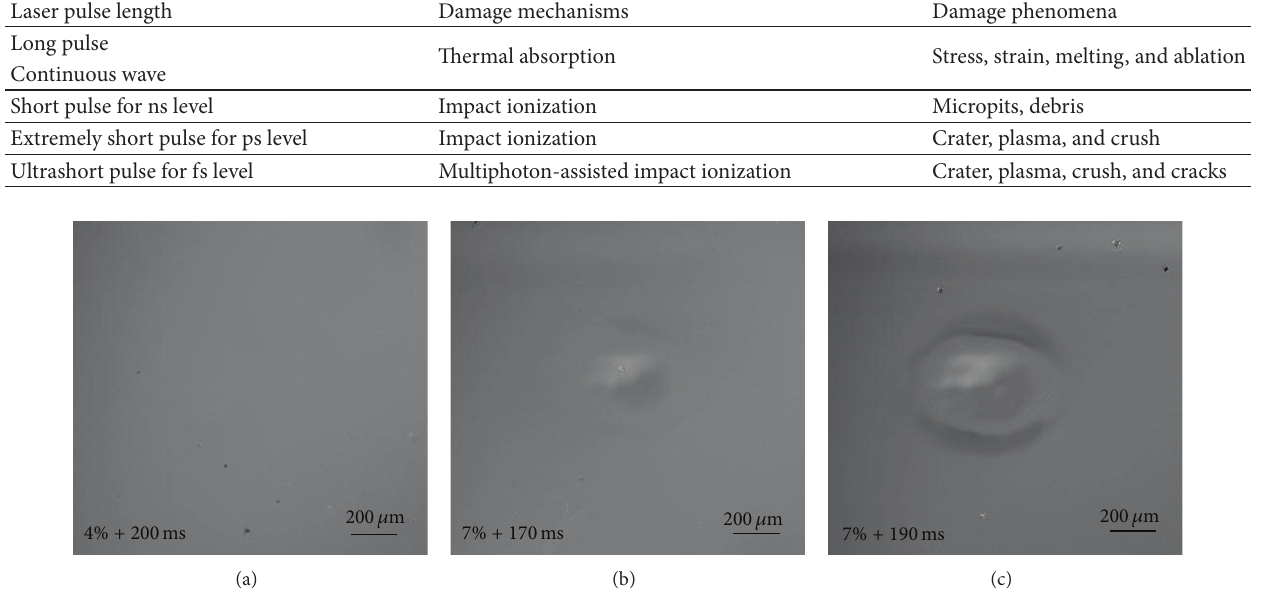
Figure 2: Three typical surface morphologies observed in the laser irradiated areas of fused silica induced by 10.6 𝜇 m CO 2 laser irradiation